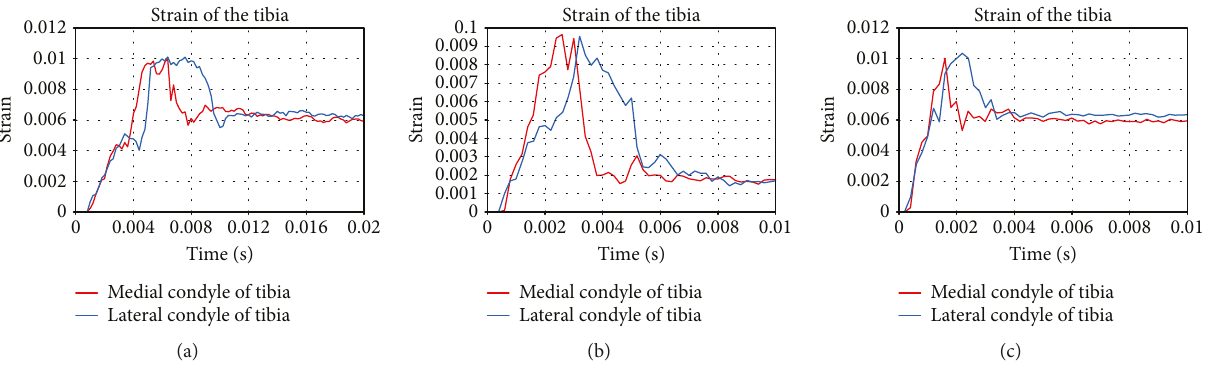
Figure 6: The strain response of medial and lateral tibial strain curves at the varied impact speeds ((a) 2.5km/h; (b) 5.0km/h; (c) 8.0km/h).